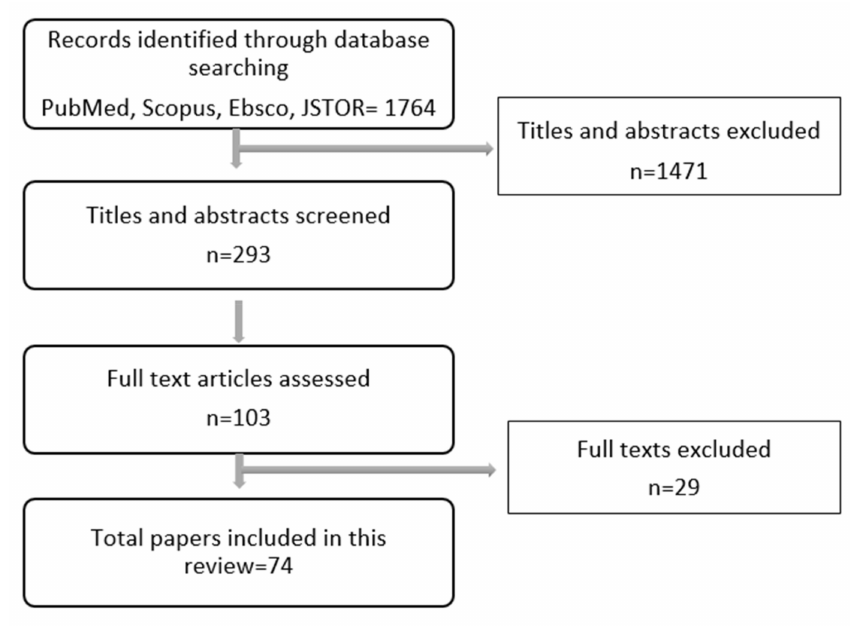
Figure 1. Flowchart of research